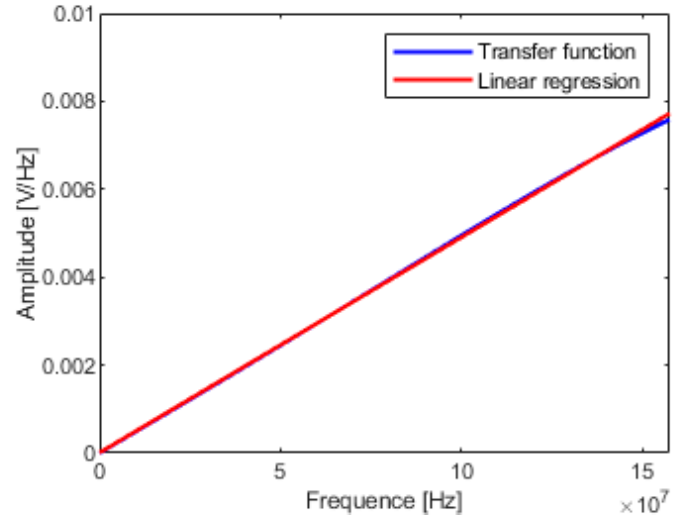
Figure 7. Partial linear regression of transfer function.